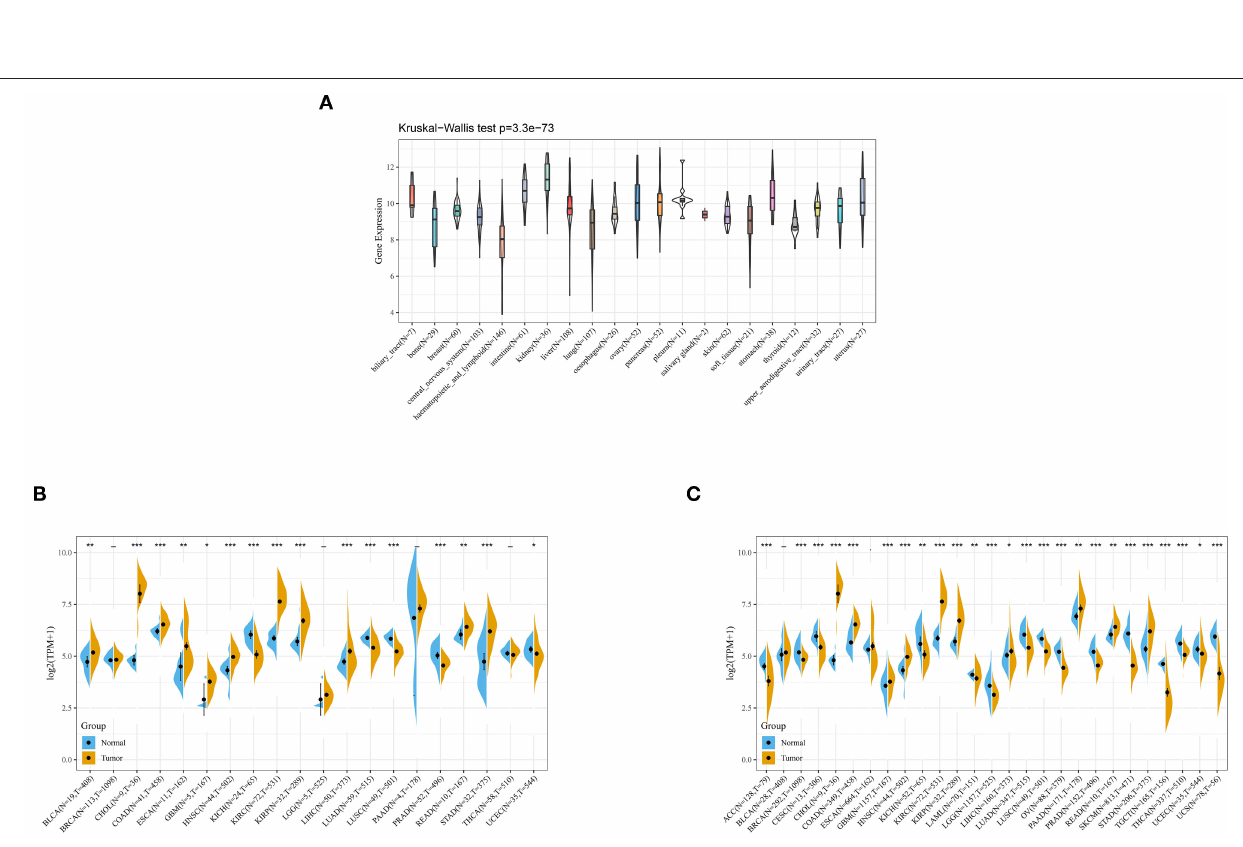
Frontiers in Cardiovascular Medicine |